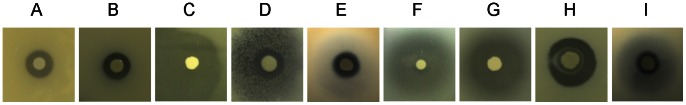
Growth inhibition of Xanthomonas species by P.putida BW11M1.Spotted BW11M1 cells (2 µl of 107 CFU/ml) were overlayed with Xanthomonas indicator cells. (A) X. alfalfae subsp. alfalfae LMG 497; (B) X. axonopodis pv. manihotis LMG 784; (C) X. hortorum pv. hederae LMG 7411; (D) X. sacchari LMG 471; (E) X. translucens pv. cerealis LMG 679; (F) X. translucens pv. graminis LMG 726; (G) X. translucens pv. hordei LMG 737; (H) X. vasicola pv. holcicola LMG 736; (I) X. vasicola pv. musacearum LMG 785.